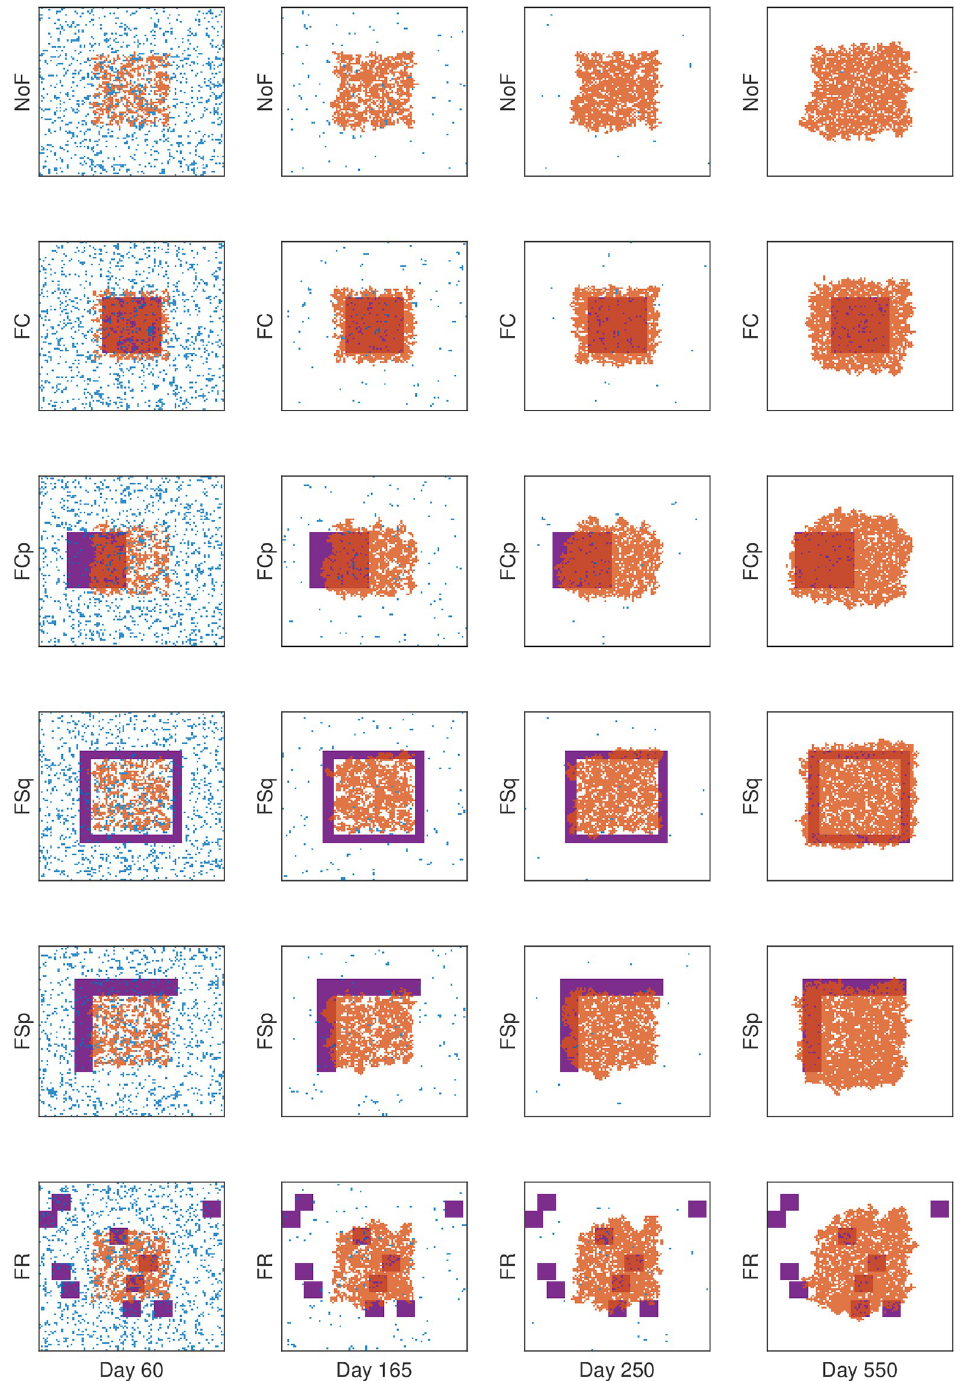
Fig 8. Cell configurations for CAF-mediated tumor growth. Cell configurations at different times under CT-MTD (continuous MTD therapy) for all type of fibroblast configurations. Each row shows results for one type of fibroblast configuration. The blue and orange dots show the S-cells and R-cells respectively and the purple shaded areas show the fibroblast regions. Specification of the fibroblast region is shown in the section Initial and boundary conditions.